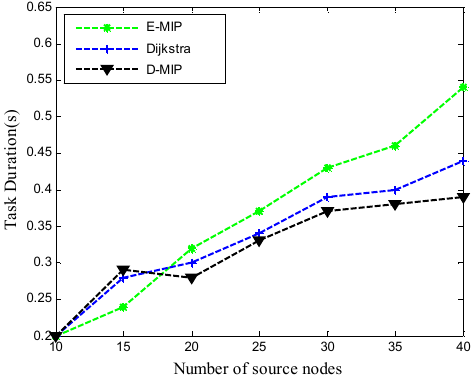
Figure 12. The effect of the number of source nodes on energy.